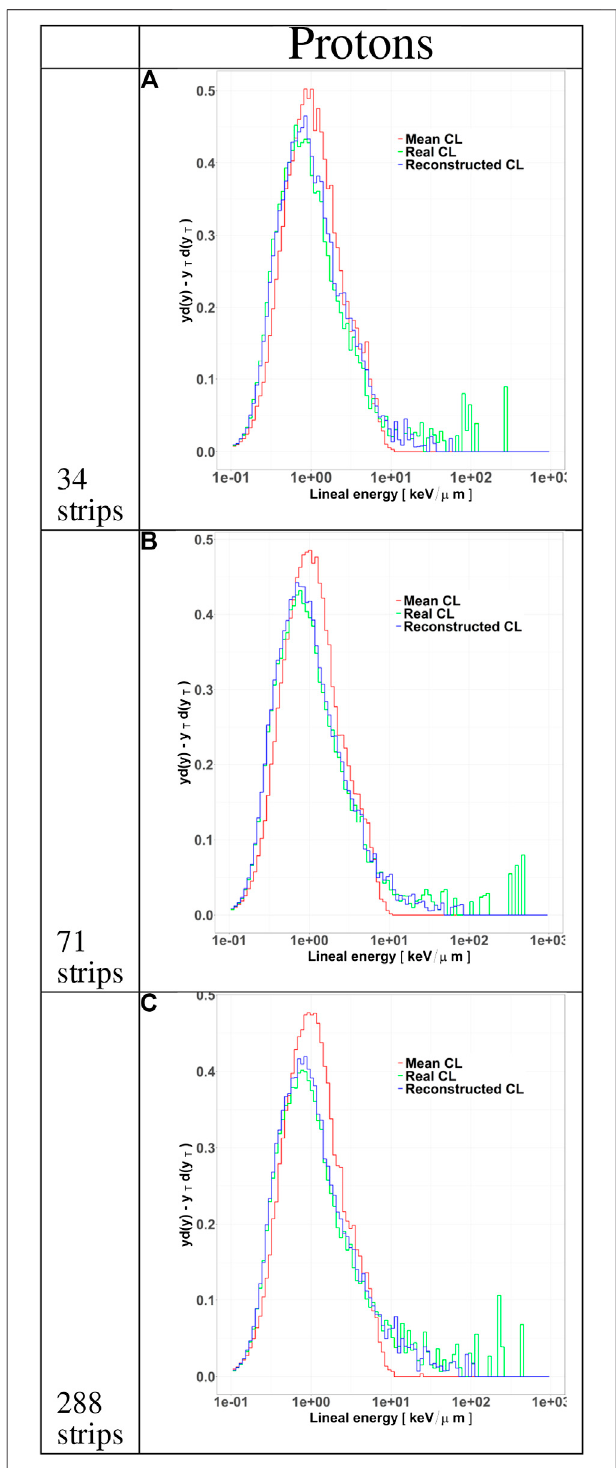
FIGURE 6 | algorithm (blue line). The distributions are shown for LGAD con fi gurations with 34 (panel A ), 71 (panel B ) and 288 (panel C )